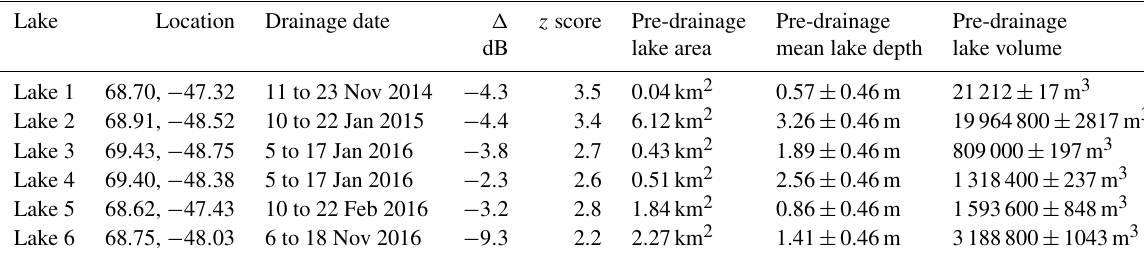
Table 1. Details of the lake drainage events. Location refers to latitude, longitude (WGS84). The drainage dates are the Sentinel-1 image dates over which the anomalous change was identified. The (cid:49) dB is the mean change in backscatter (measured in decibels) within the lake boundary from one image to the next. The z score is the measure of the magnitude of this backscatter change compared to the backscatter change of other lakes in the study site across the same image pair. Lake area is the size of the lake delineated by the NDWI ice -based mask. Lake volume was calculated as described in